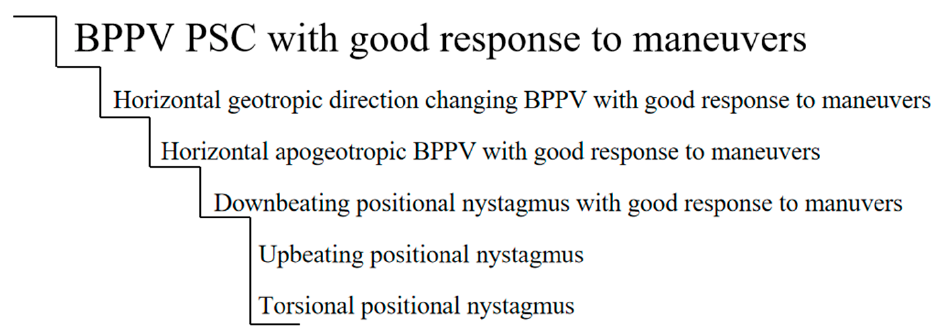
Figure 1. Ladder of